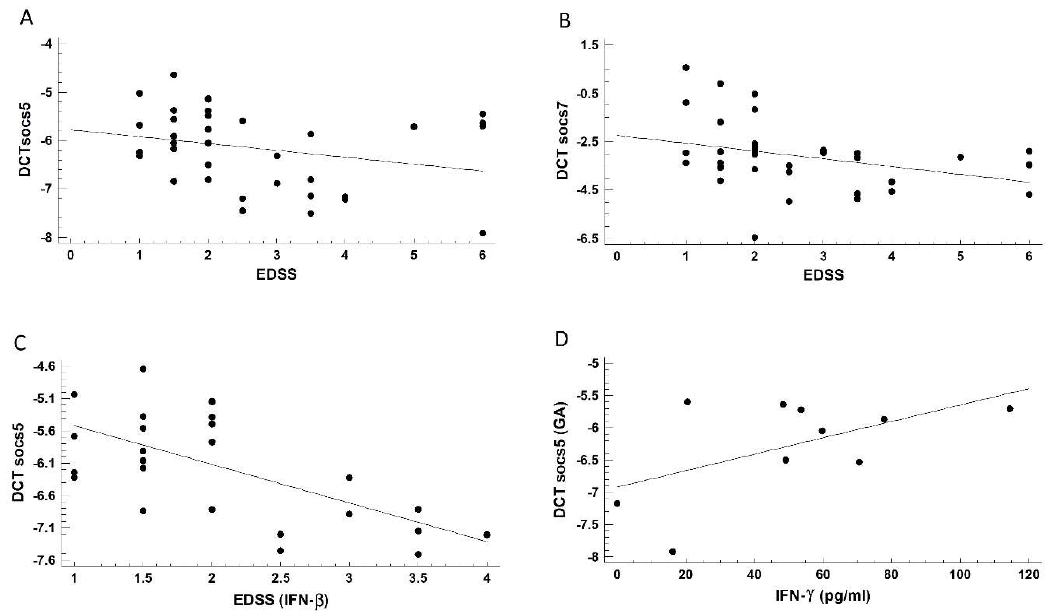
Figure 5. Correlation analysis between socs, EDSS score, and cytokine concentrations. The correlation was calculated using Spearman´s correlation coefficient. ( A ) and ( B ) Correlation between SOCS5 or SOCS7 and EDSS score. ( C ) In patients treated with IFN- β , a correlation was found between